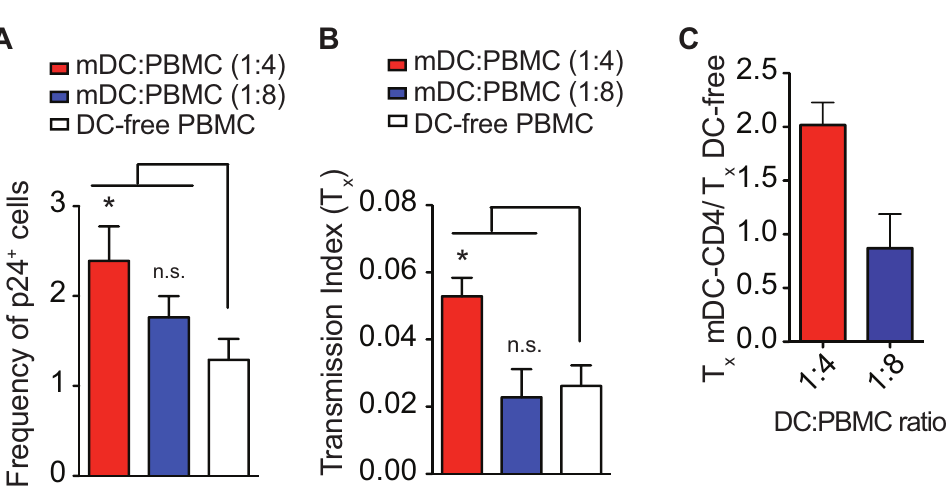
Fig 5. HIV transmission between primary myeloid DCs and CD4 + T cells is capable of drug-insensitivity. Primary myeloid DCs (mDCs) were cocultured with autologous CD4 + T cells at ratios of 1:4 and 1:8. ( A ) The mDC-CD4 + T cell cocultures and DC-free CD4 + T cell cultures were infected with NL4-3 and the frequency of infected p24 + T cells was measured using flow cytometry. ( B ) The mDC-CD4 + T cell cocultures and DC-free CD4 + T cell cultures were infected with NL4-3 in the presence or absence of 10 μ M of TFV and drug insensitivity (T x ) was measured. ( C ) Fold difference between the T x values of mDC-CD4 + T cell coculture and DC-free culture were measured. Mean ± s.e.m ( η = 3 technical replicates). (cid:3) , p < 0.05 (student’s T-test); n.s., p > 0.05. Data is representative of one donor from two independent experiments ( A - C